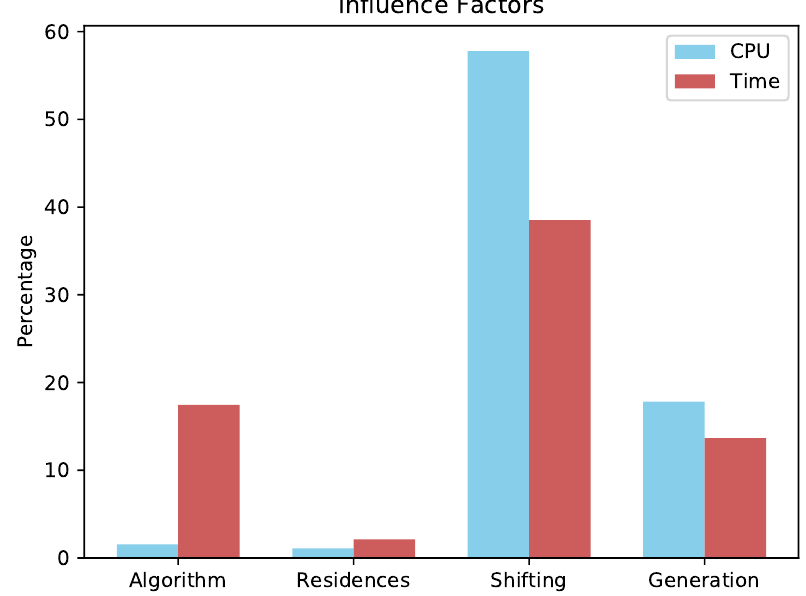
Figure 7. Influence factors in the studied scenario.